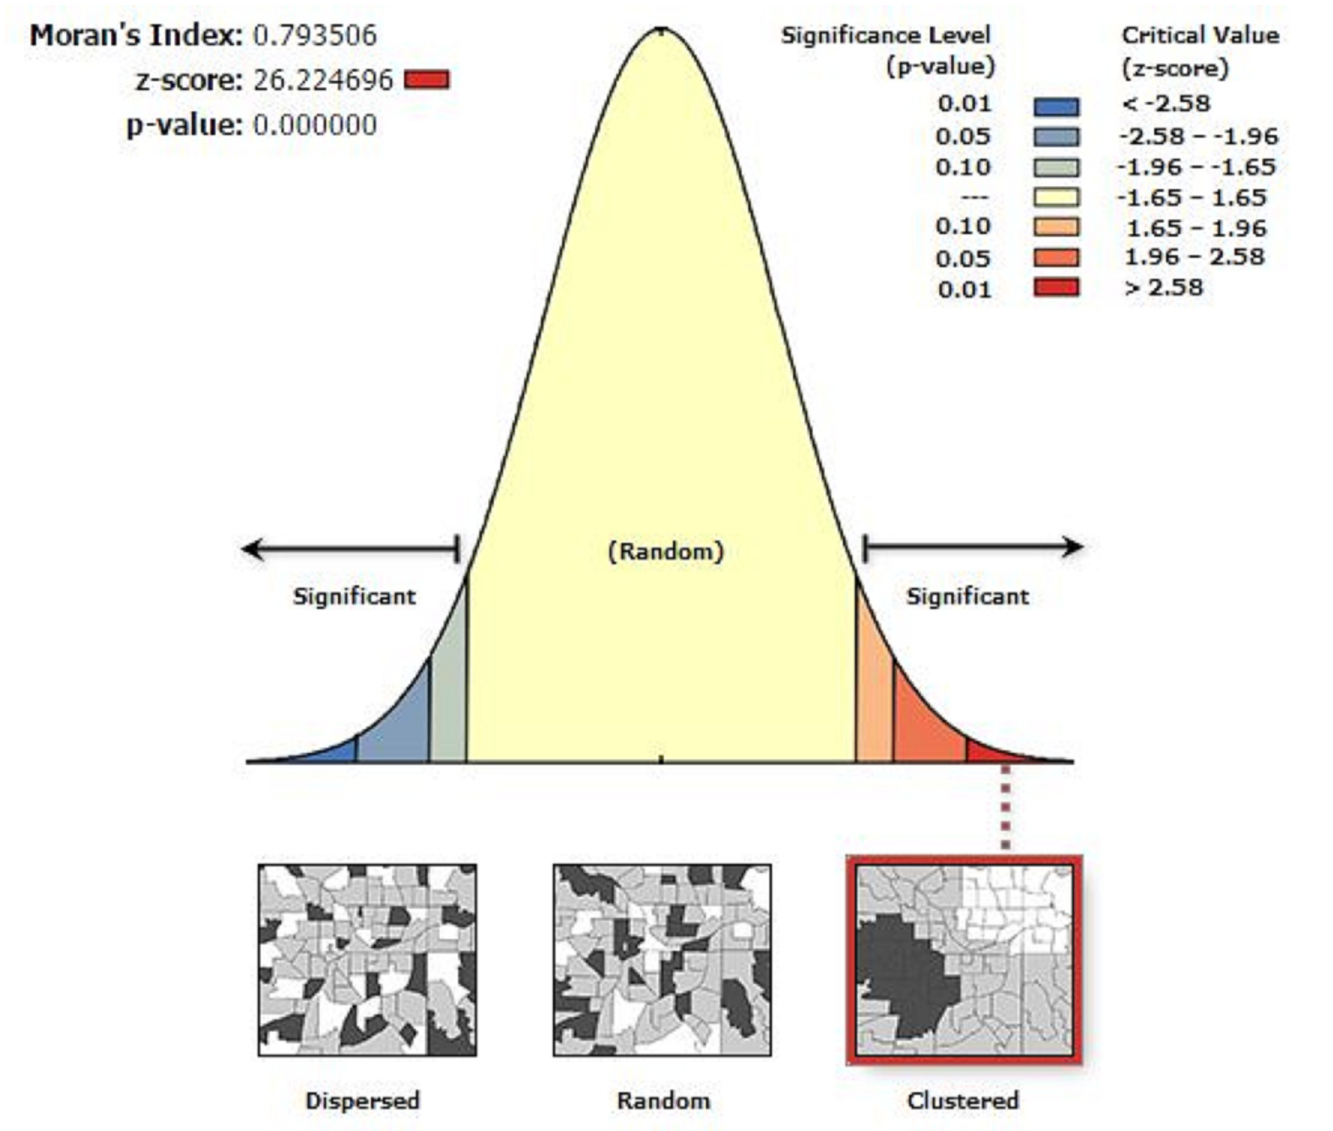
Fig 1. Spatial autocorrelation analysis of underweight among individuals aged 15–49 years in Ethiopia,